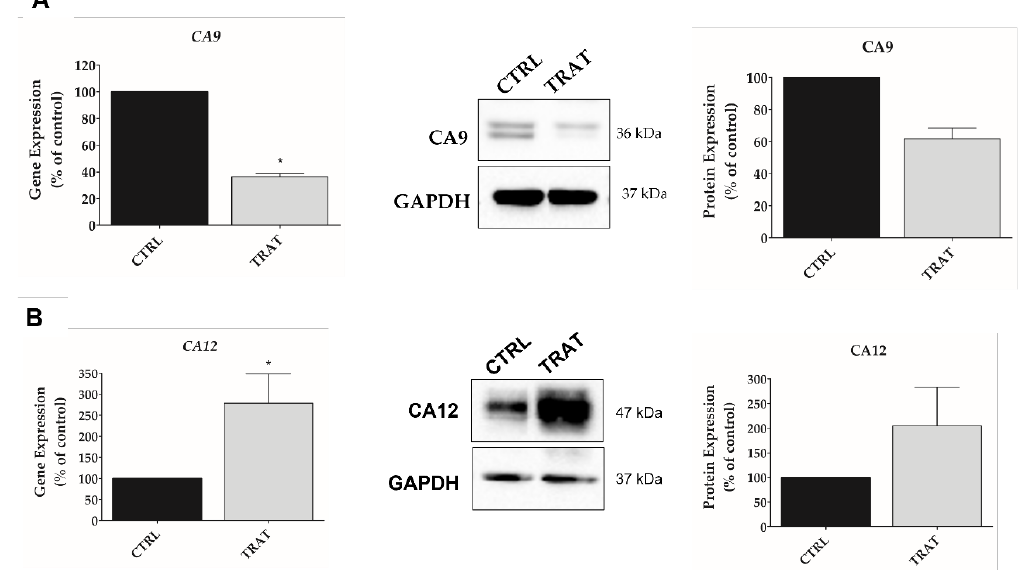
Figure 6. Indisulam decreases CA9 and increases CA12 expression in pHGG cells under hypoxia. SF188 cell line was incubated for 24 h under mimetic hypoxia condition (CoCl 2 50 μM) and treated with Indisulam (IC 50 ) for 48 h. Gene and protein expression of CA9 ( A ) and CA12 ( B ) were measured by qRT-PCR and Western blotting, respectively. The bar graphs and Western blot image indicate that, the treatment of SF188 cells with Indisulam reduces CA9 gene and protein expression, while increasing the expression of CA12 compared to control. CTRL: control; TRAT: treatment with the Indisulam; GAPDH was used as loading control; quantification of relative expression was determined using ImageJ software. * p <